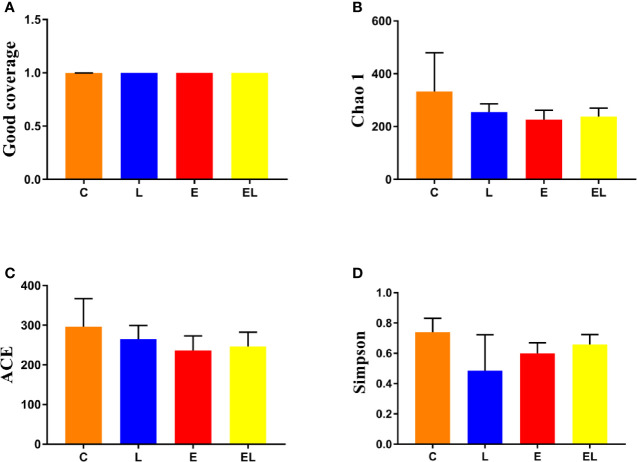
Comparison of alpha diversity of mice gut microbiota in different groups. Four indices such as Good's coverage (A), Chao1 (B), ACE (C), and Simpson (D) were used to assess the alpha diversity of gut microbiota. The data used in this study were expressed as the mean ± SD.